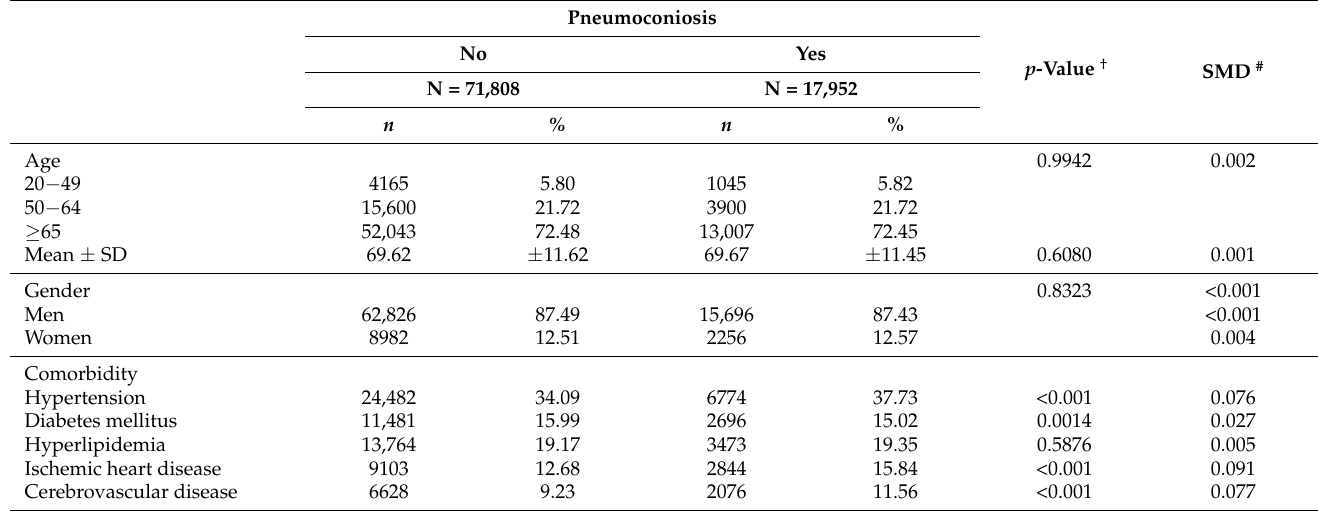
Table 1. Characteristics for individuals with and without